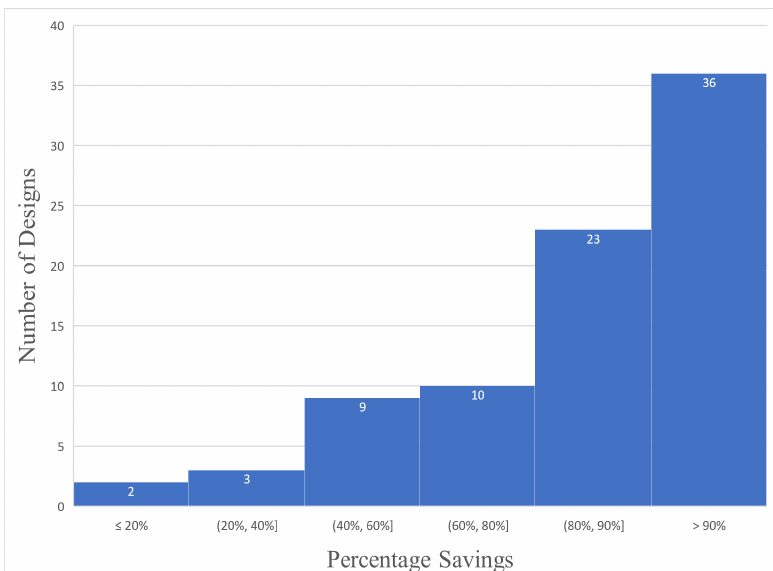
Figure 8: Percentage savings for the designs that saved prosumers money for self fabrication for commercial filament. The mean and the standard deviation for the percent money saved for the projects that saved users money for self fabrication using each of the material types: 1) commercial filament, 2) commercial pellets, 3) recycled commercial pellets and 4) self-consumer plastic is shown in Figure 9.